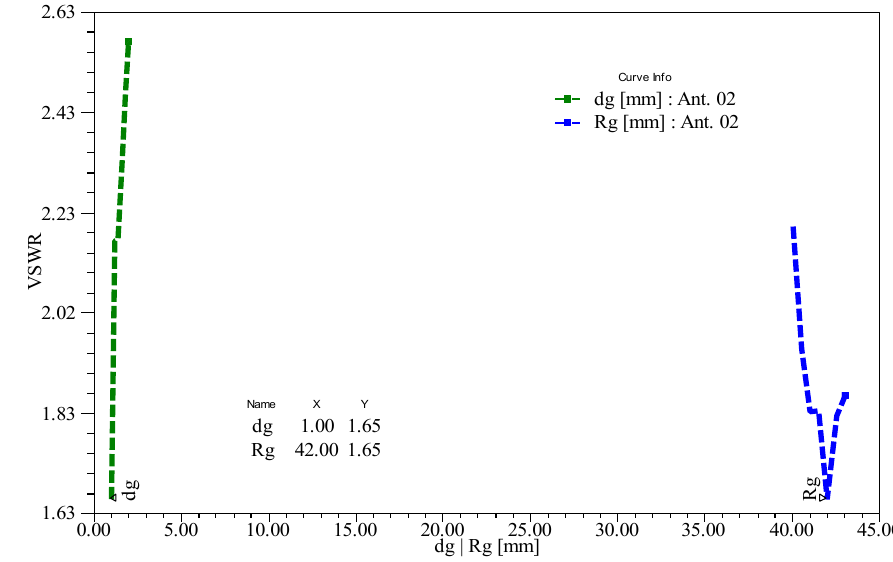
Figure 9. VSW R of Slot antenna 2 at 2450 MHz versus dg and Rg (mm). Figure 9. VSWR of Slot antenna 2 at 2450 MHz versus dg and Rg